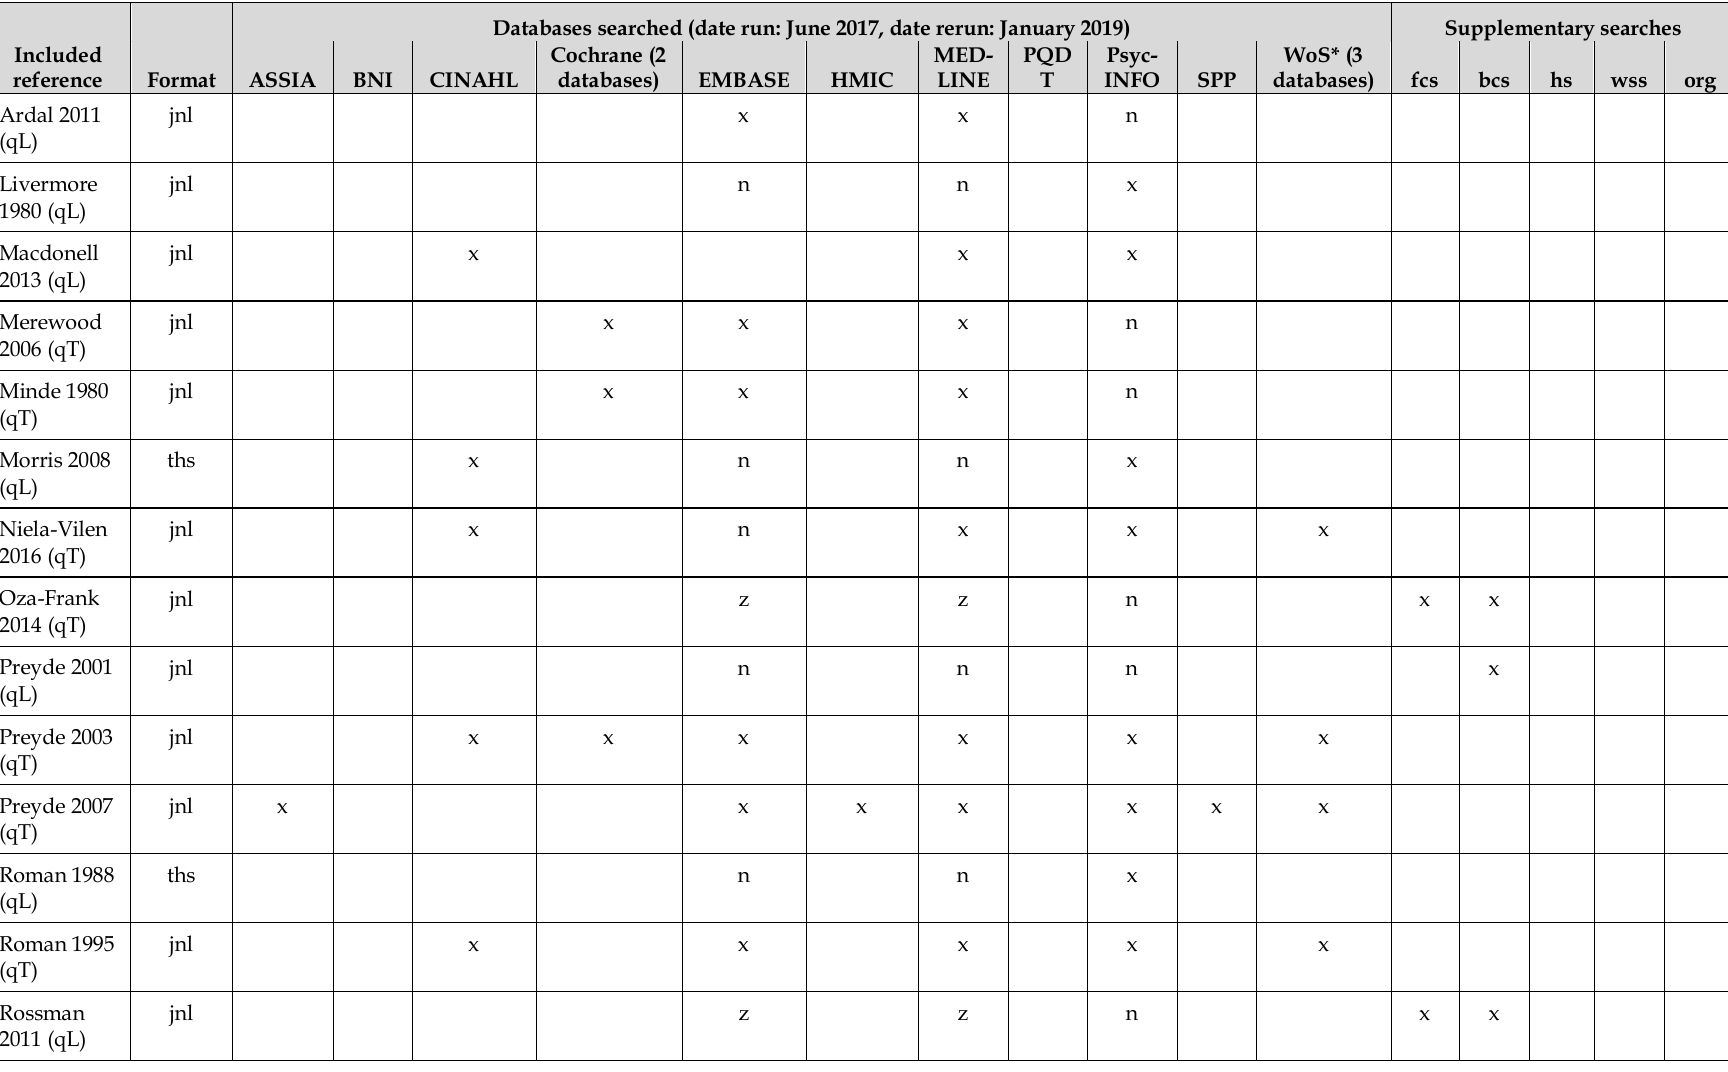
Table 3 Completed SST for Hunt et al.’s systematic review, ‘“They’ve Walked the Walk’: A Systematic Review of Quantitative and Qualitative Evidence for Parent-To-Parent Support for Parents of Babies in Neonatal Care”